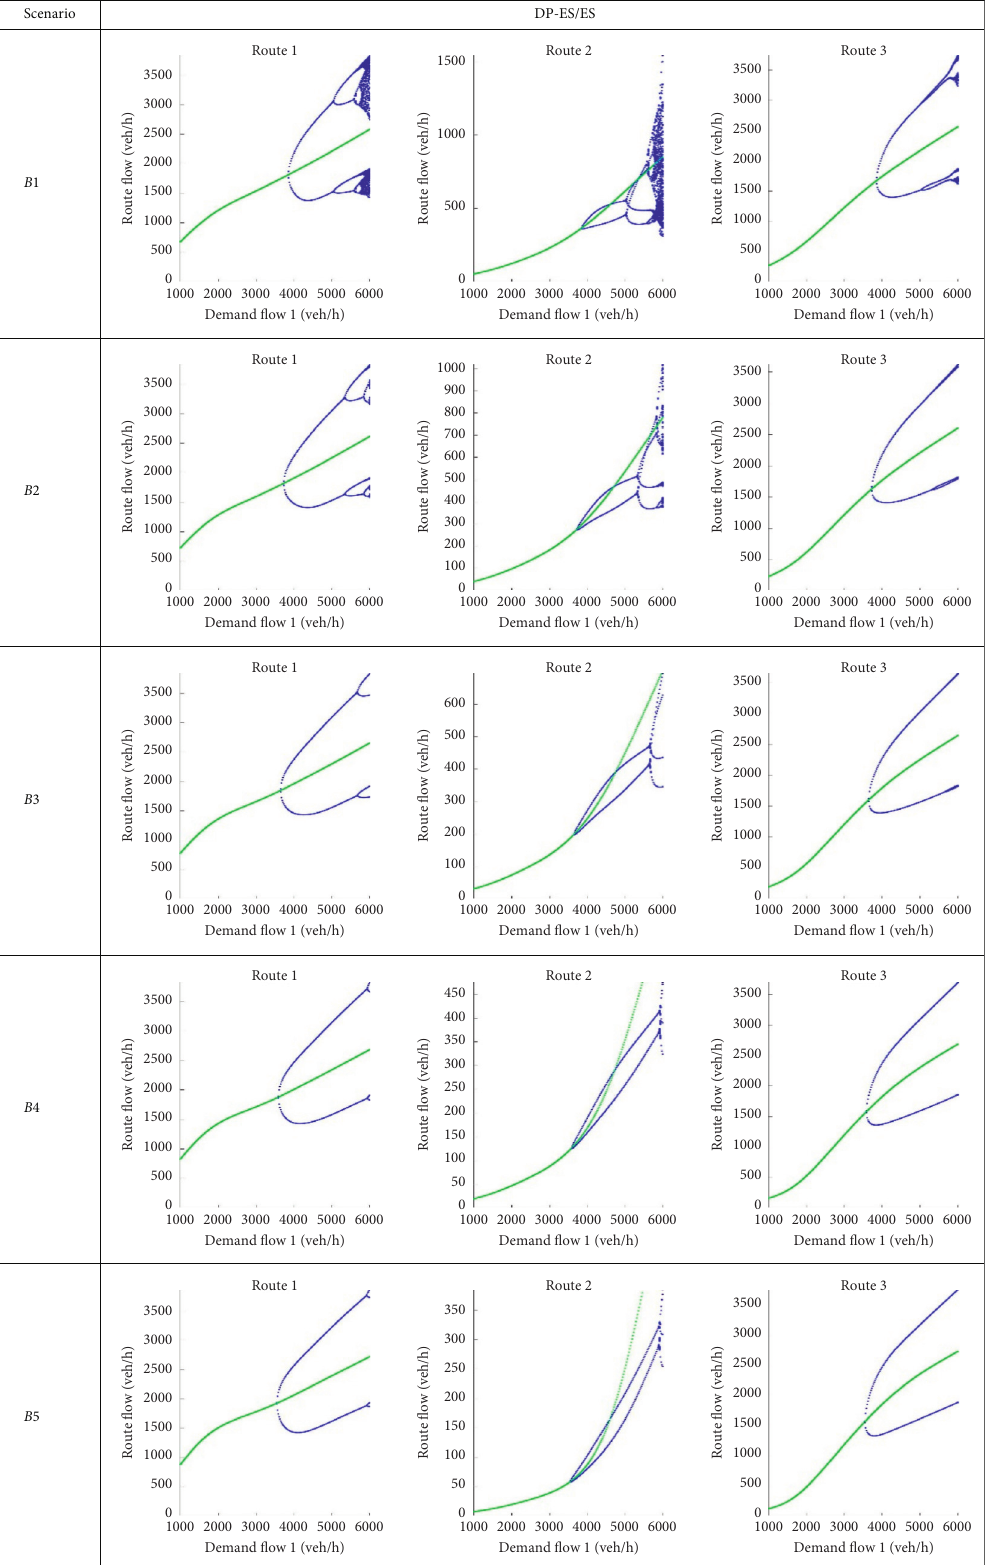
Figure 4: Bifurcation diagrams of route flows, scenarios A, ES/ES with θ